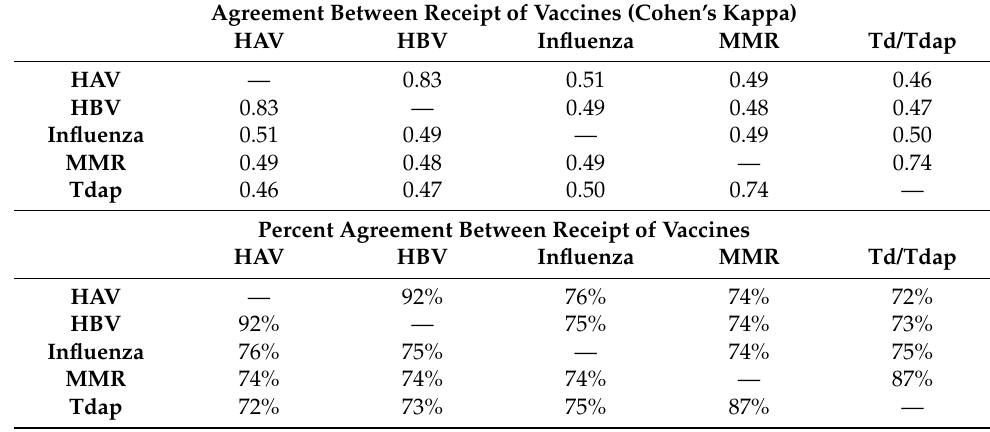
Table 3. Patterns of vaccine receipt ( N =